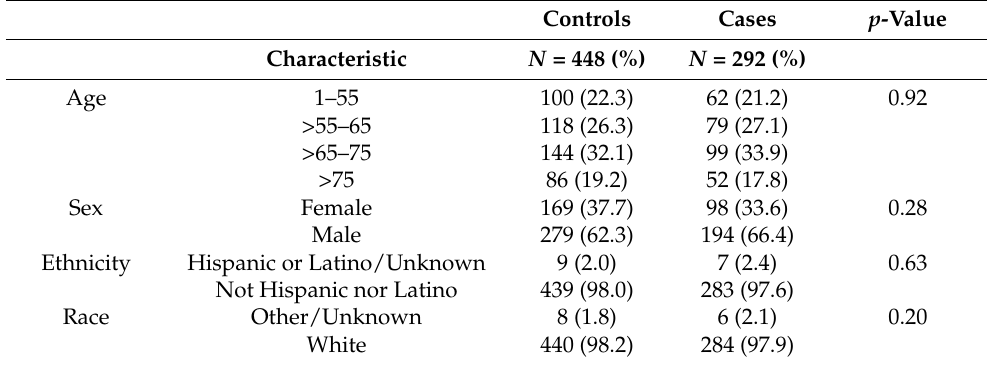
Table 1. New Hampshire case-control population characteristics.